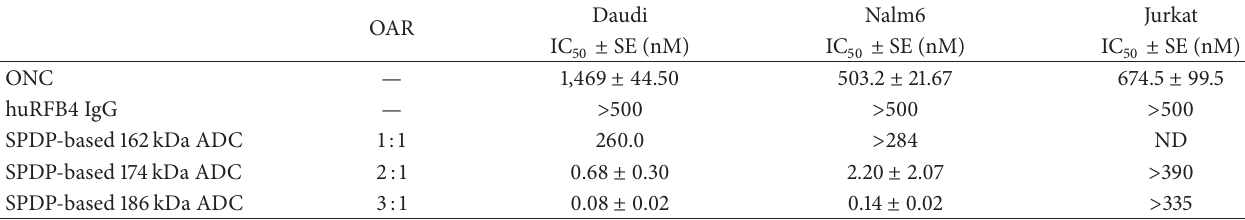
Table 2: Dose- and DAR-dependent in vitro cytotoxicity of SPDP-based ADCs.